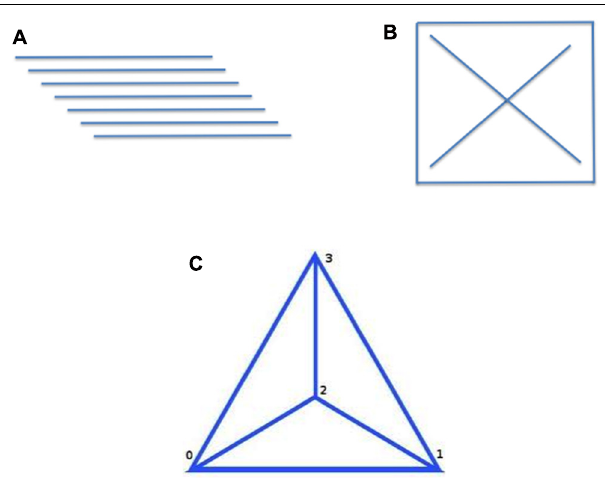
FIGURE 3 | The triangle problem (Katona, 1940) . The goal of the task is to arrange six sticks of equal length (A) into four equilateral triangles. (B) While one can form four triangles in two-dimensional space, they will not be equilateral. (C) Once the third dimension is considered, the solution presents